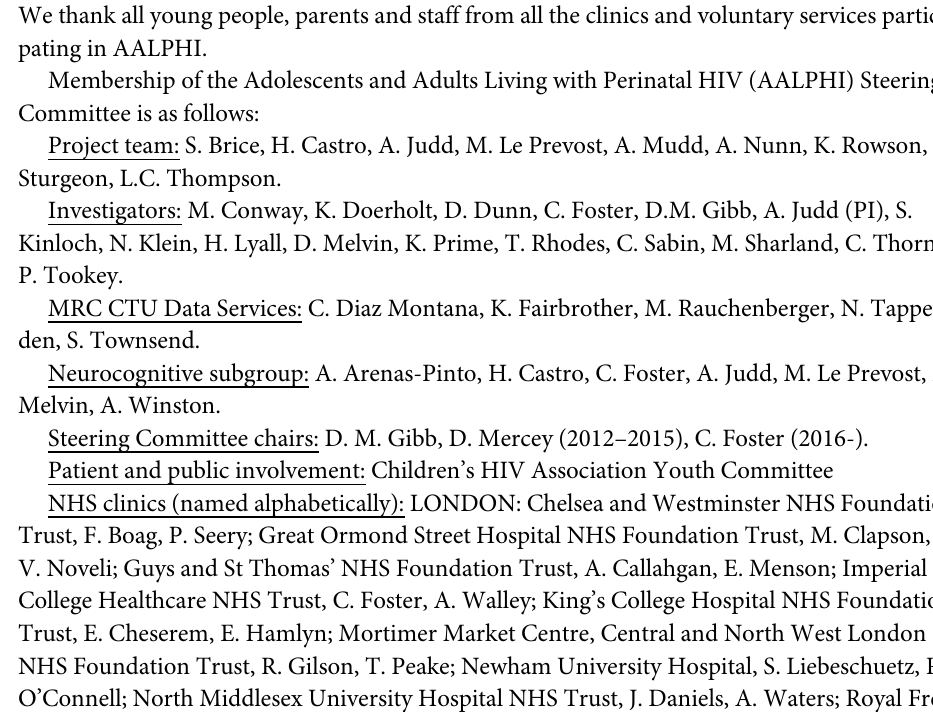
S3 Table. Predictors of improved verbal learning, verbal delayed recall and executive func- tion scores for PHIV participants. All a priori variables, as well as those with univariable P- value < 0.15 and multivariable P-value < 0.05 are presented. Abbreviations: CI, confidence interval, HIV-, HIV negative; PHIV, perinatal HIV; PHIV/C, PHIV with a CDC C diagnosis; PHIV/no C, PHIV without a CDC C diagnosis; NNRTI, non-nucleoside reverse transcriptase inhibitor; PI, protease inhibitor; NRTI, nucleoside reverse transcriptase inhibitor. a within 6 months before or after